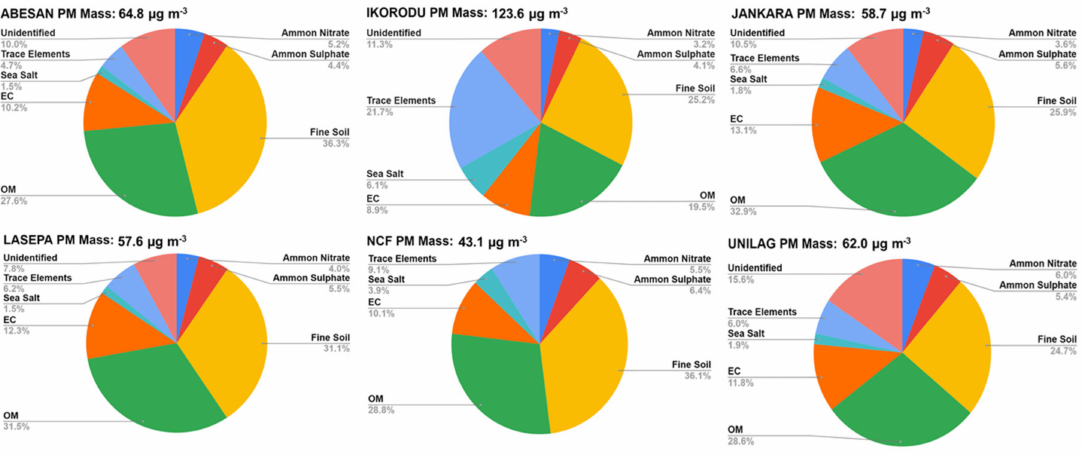
Figure 10. Pie charts for PM 2.5 showing percentage of components by apparent source to total mass concentration from CMB